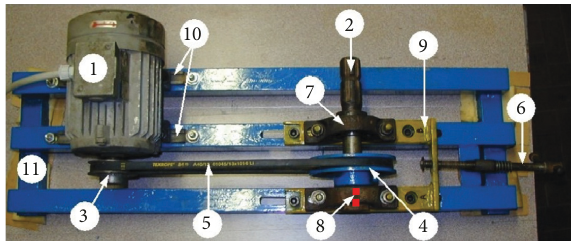
Figure 1: Test rig. 1, electric motor; 2, countershaft; 3, driving pulley; 4, driven pulley; 5, trapezoidal belt; 6, pretensioning system; 7, undamaged bearing; 8, faulty bearing; 9, positioning slide; 10, fixing rail for the electric motor; 11, platform. Red squares rep- resent the two accelerometers mounted one vertical and one along the axis of the